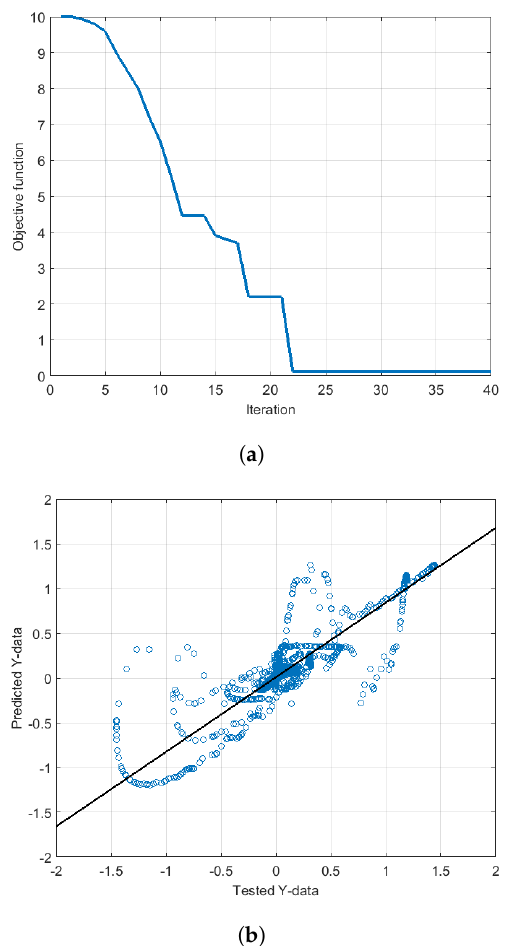
Figure 7. Basic ANN Performance. ( a ) RMSE against number of iteration. ( b ) Regression